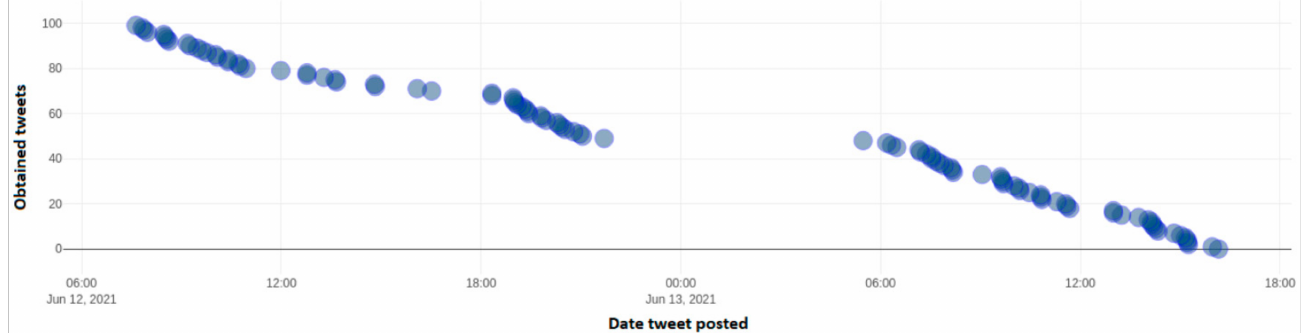
Figure 19. Mined tweets based on negative hashtag (#N ∆ _ ρ o µπε ς ) (100 tweet sample) for New Democracy